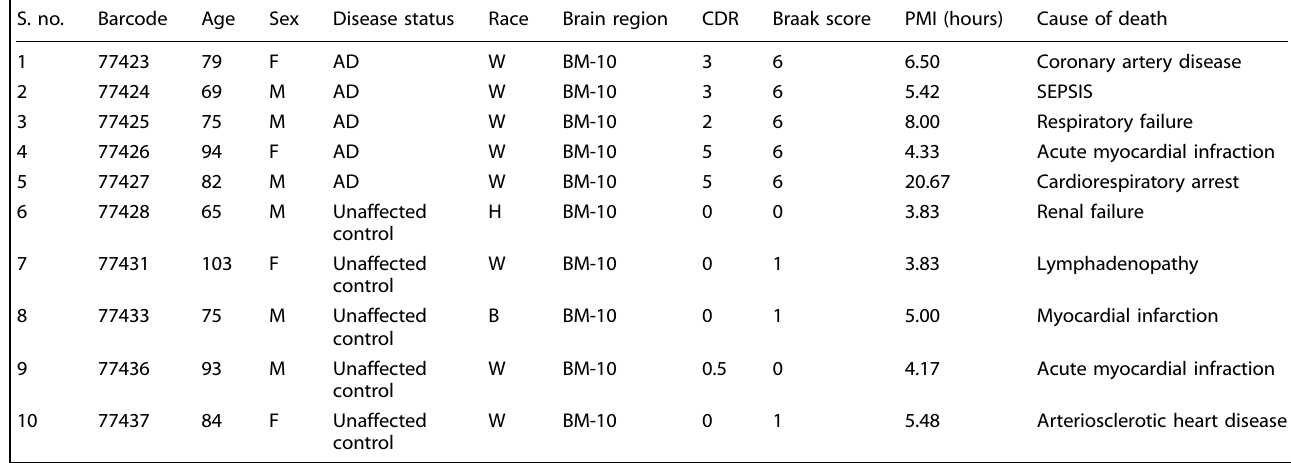
Table 1. Demographic and clinical details of postmortem brains used for Affymetrix microarray analysis. S.